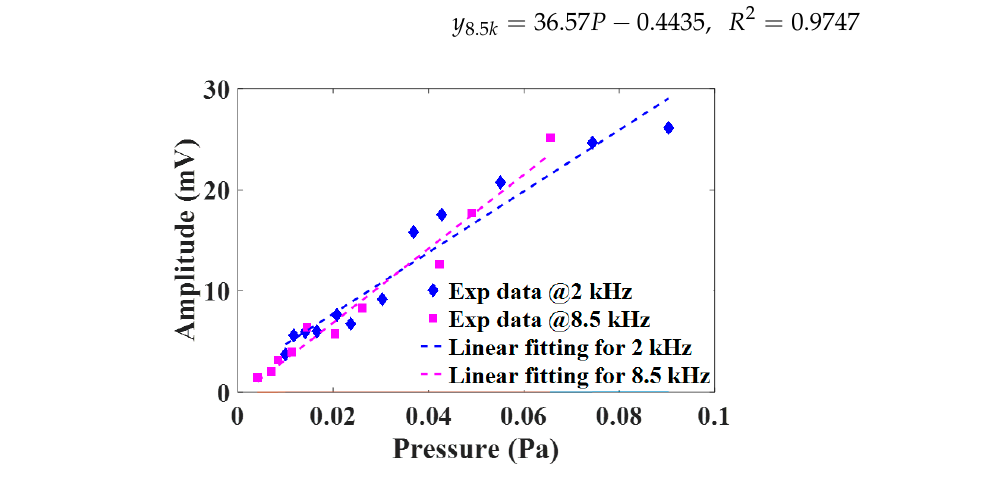
Figure 9. Acoustic frequency response of the fabricated sensor at 2 and 8.5 kHz.